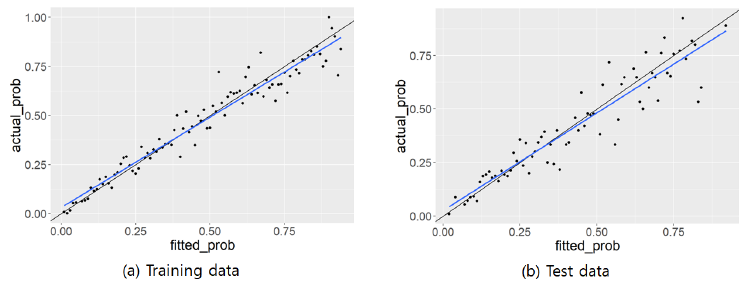
Figure 3. Calibration plot of nomogram for metabolic